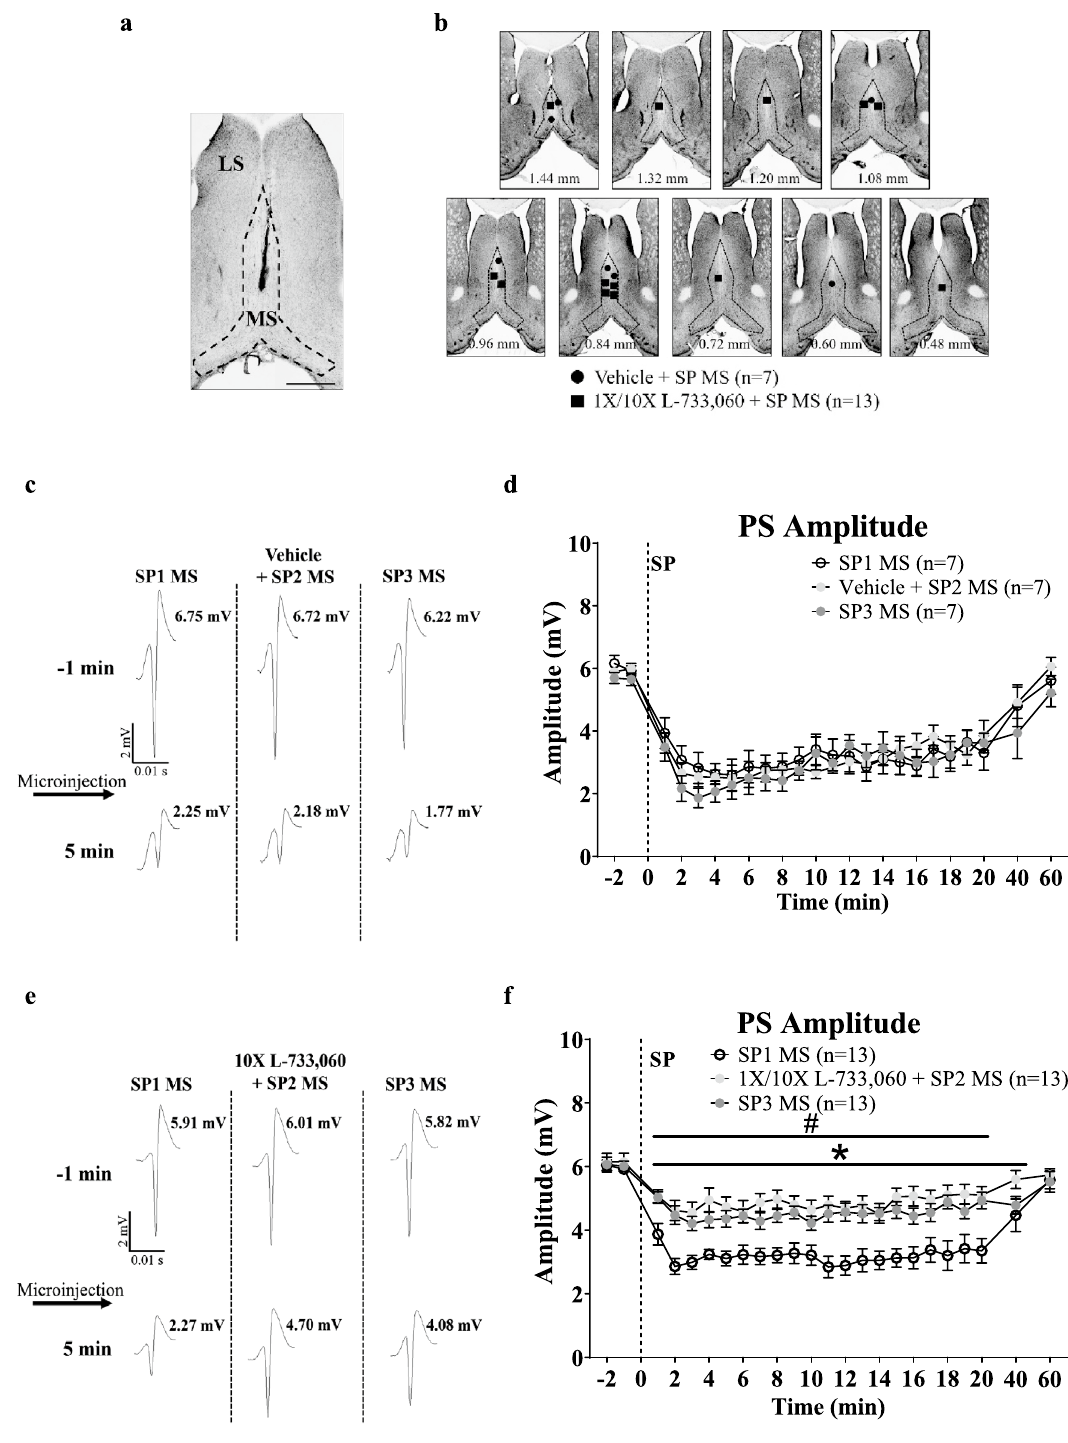
Figure 3. Microinjection of neurokinin 1 receptor (NK1R) antagonist, L-733,060, into the medial septum (MS) blocked Substance P (SP)-induced suppression of CA1 population spike (PS) in anaesthetised animals. A double- barrelled cannula was used for microinjection of the drugs. SP (2 µg/µl, 0.5 µl; posterior cannula) was microinjected three times (SP1, SP2, SP3), at least 1 h apart, with vehicle or L-733,060 (1 ×, 0.0176 µg/µl; 10 ×, 0.176 µg/µl, 0.5 µl; anterior cannula) microinjected 15 min before SP2. ( a ) Representative microinjection site in the MS. Scale bar represents 1 mm. ( b ) Composite of microinjection sites in the MS built as in Fig. 1. ( c , e ) The PS traces representing the average PS before (− 1 min) and after (5 min) SP microinjection. Numbers next to each trace reflects the computed PS amplitude. Arrow indicates microinjection of SP. ( d , f ) Time course of effect of pre-treatment with vehicle ( d ) or L-733,060 ( f ) on SP-induced suppression of PS. Notice the robust decrease in amplitude of PS amplitude with repeat microinjection of SP in vehicle pre-treated animal ( c , d ) which is attenuated on pre-treatment with the antagonist ( e , f ). Data are mean ± S.E.M. Significant difference (p < 0.05): ( f ) *1 ×/10 × L-733,060 + SP2 MS vs. SP1, # SP3 vs. SP1 MS; two-way RM ANOVA followed by Bonferroni post-hoc